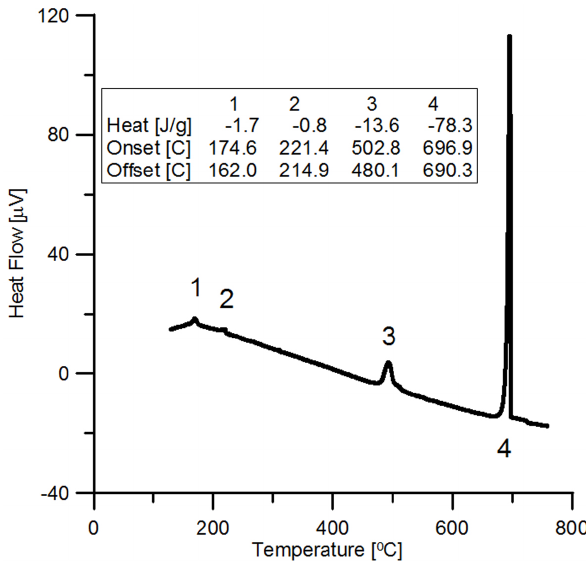
Figure 3: DSC curve of the alloy no